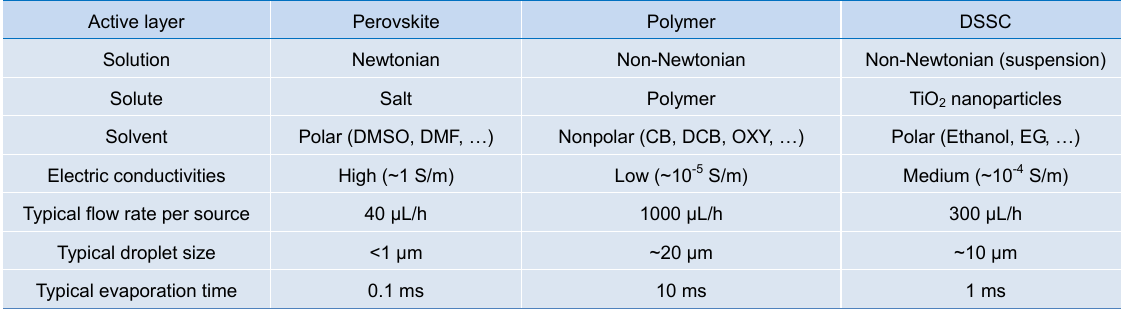
Table 1 | Comparison of electrospray printed active layers of three different solar